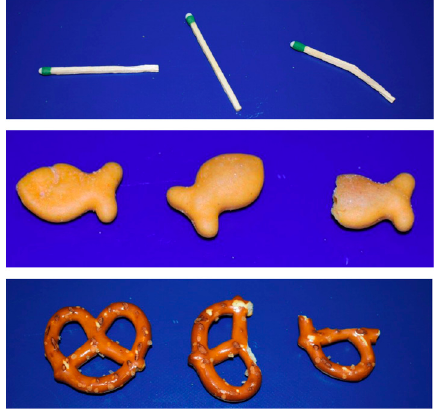
Figure 7. Sample images of three simple application cases.